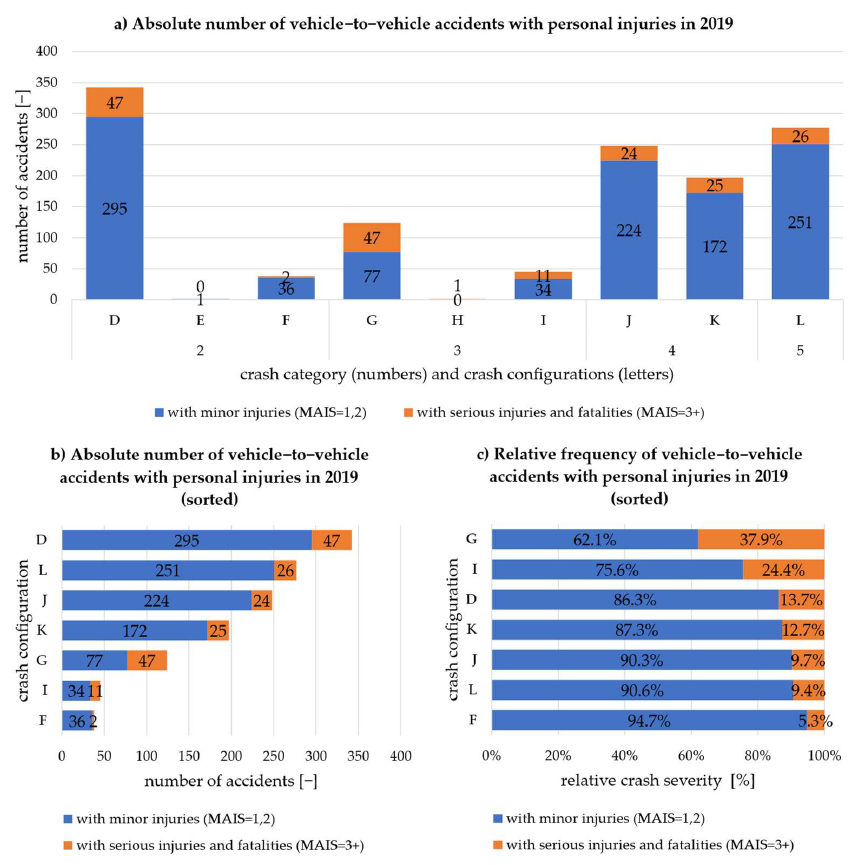
Figure 2. Vehicle-to-vehicle crashes with personal injury in 2019 according to CISS [19] broken down into crash configurations: ( a ) absolute number of all crash configurations; ( b ) absolute number of all relevant crash configurations sorted; ( c ) relative frequency of severe crashes sorted by the largest relative proportion of serious injuries and fatalities.